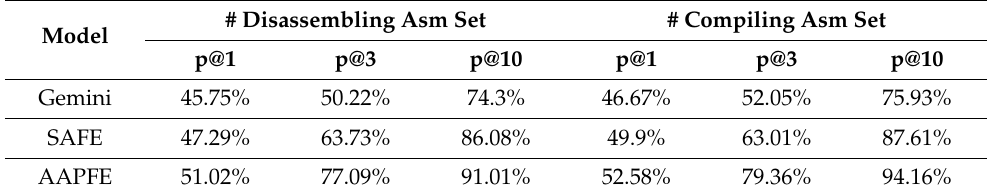
Figure 9. Precision and accuracy curve in similarity comparison task: ( a ) precision curve; ( b ) accuracy curve. Table 5. Comparison with the baseline using p@N